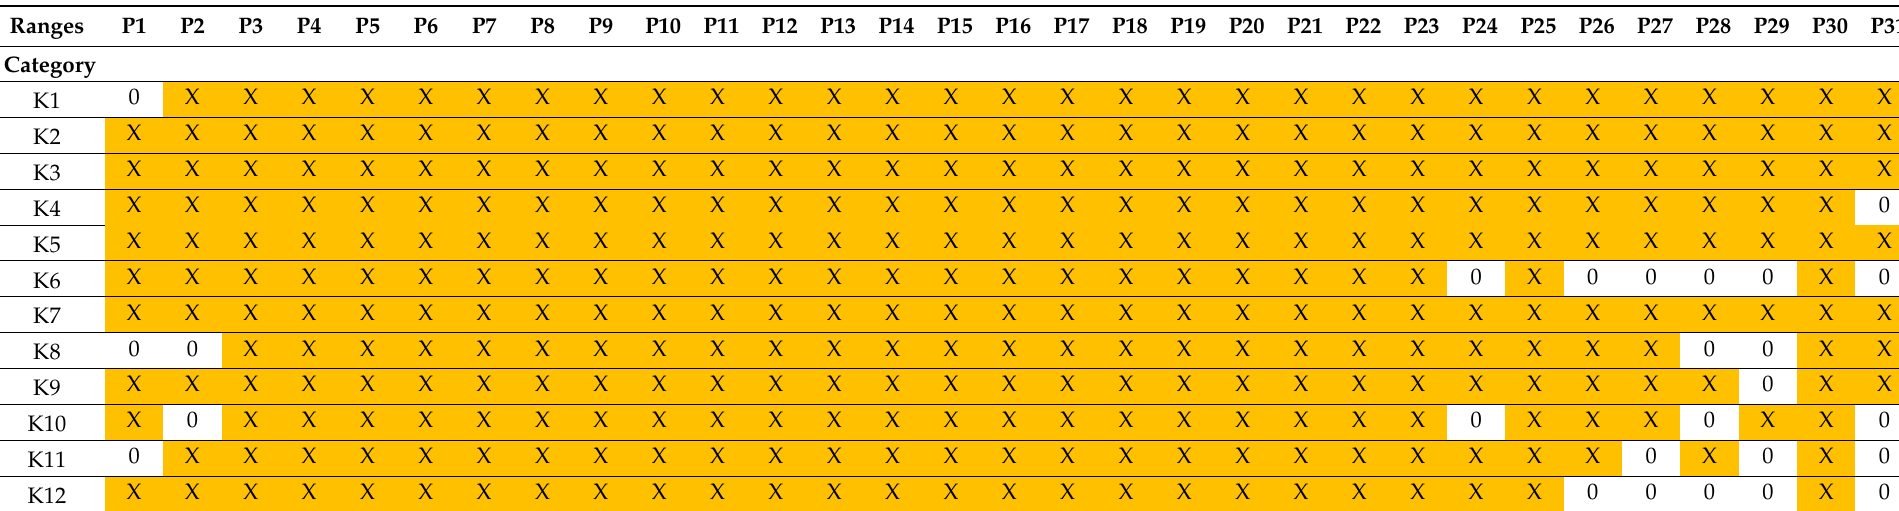
Table 10. KA matrix: project categories according to the duration of the